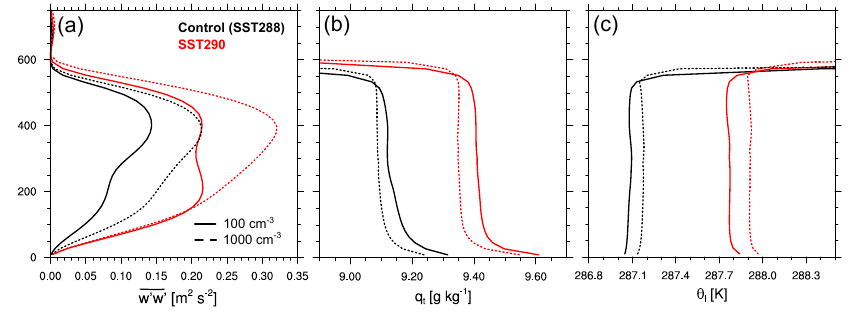
Fig. 7. Vertical profile averaged over 4–6h of (a) mean vertical velocity variance, (b) mean total water mixing ratio q t , and (c) mean liquid water potential temperature θ l for Control (black)/SST290 (red) and clean (solid line)/polluted (dashed line) case.